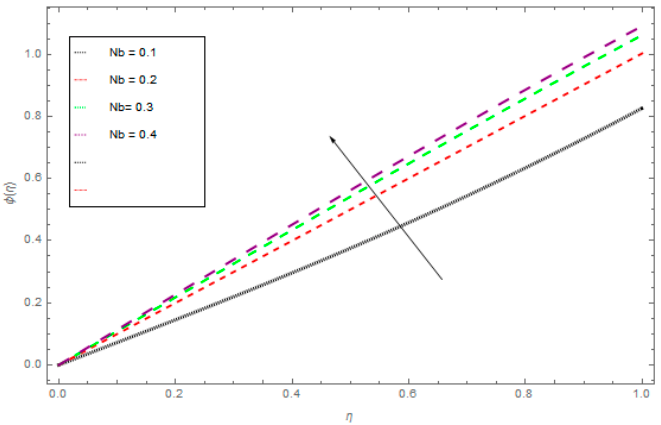
Coatings 2019 , 9 , x FOR PEER REVIEW ff ect of Nb on φ ( η ) when Nt = 0.6, Sc = 0.6, S = 0.7. Figure 8. The effect of Nb on ϕ ( η ) when Nt = 0.6, Sc = 0.6, S = 0.7. Figure 8. The e